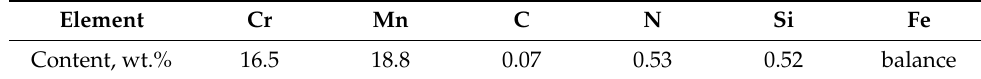
Table 1. Chemical composition of the studied steel. Element Cr Mn C N Si Fe Content, wt.% 16.5 18.8 0.07 0.53 0.52